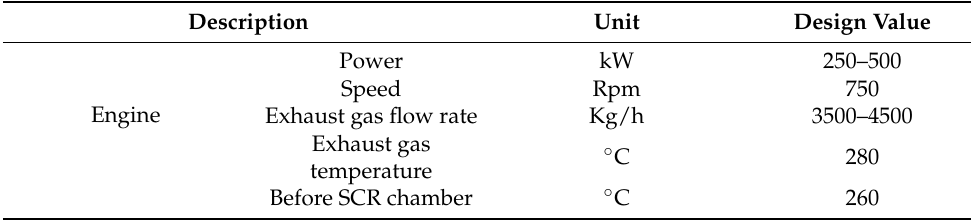
Figure 2. Direct photos of the plasma burner assisted SCR system. Table 1. Operating conditions of medium speed marine engines.